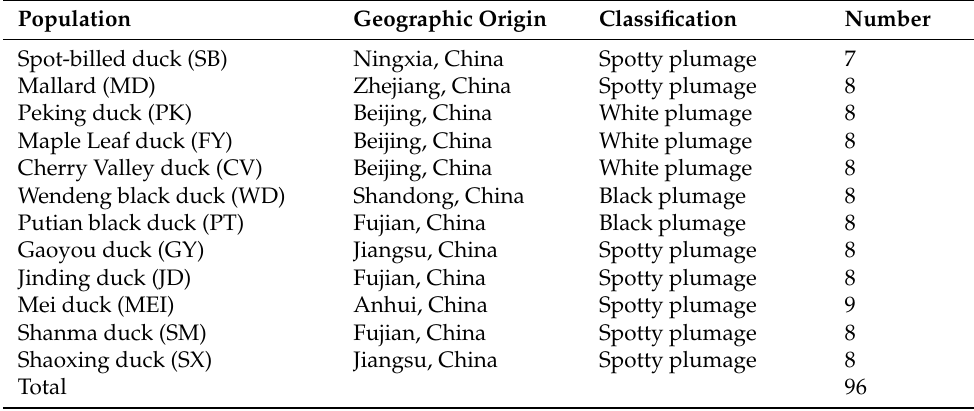
Table 1. Overview of duck populations used in this